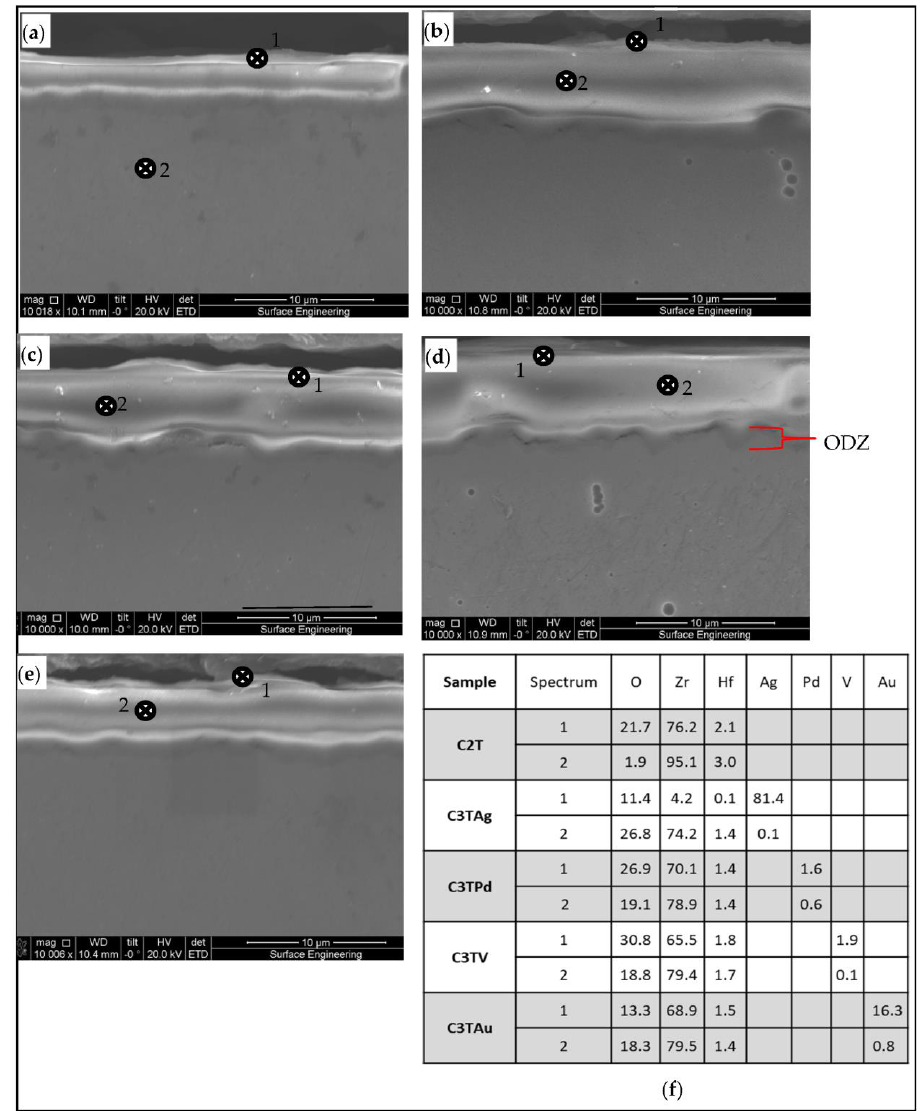
Figure 5. The SEM images of the surface layer structure for samples of ( a ) C2T; ( b ) C3TAg; ( c ) C3TPd; ( d ) C3TV; ( e ) C3Tau; and ( f ) EDX analysis of ( a – e ) samples from position 1 and 2, as denoted, compositions are in wt%.